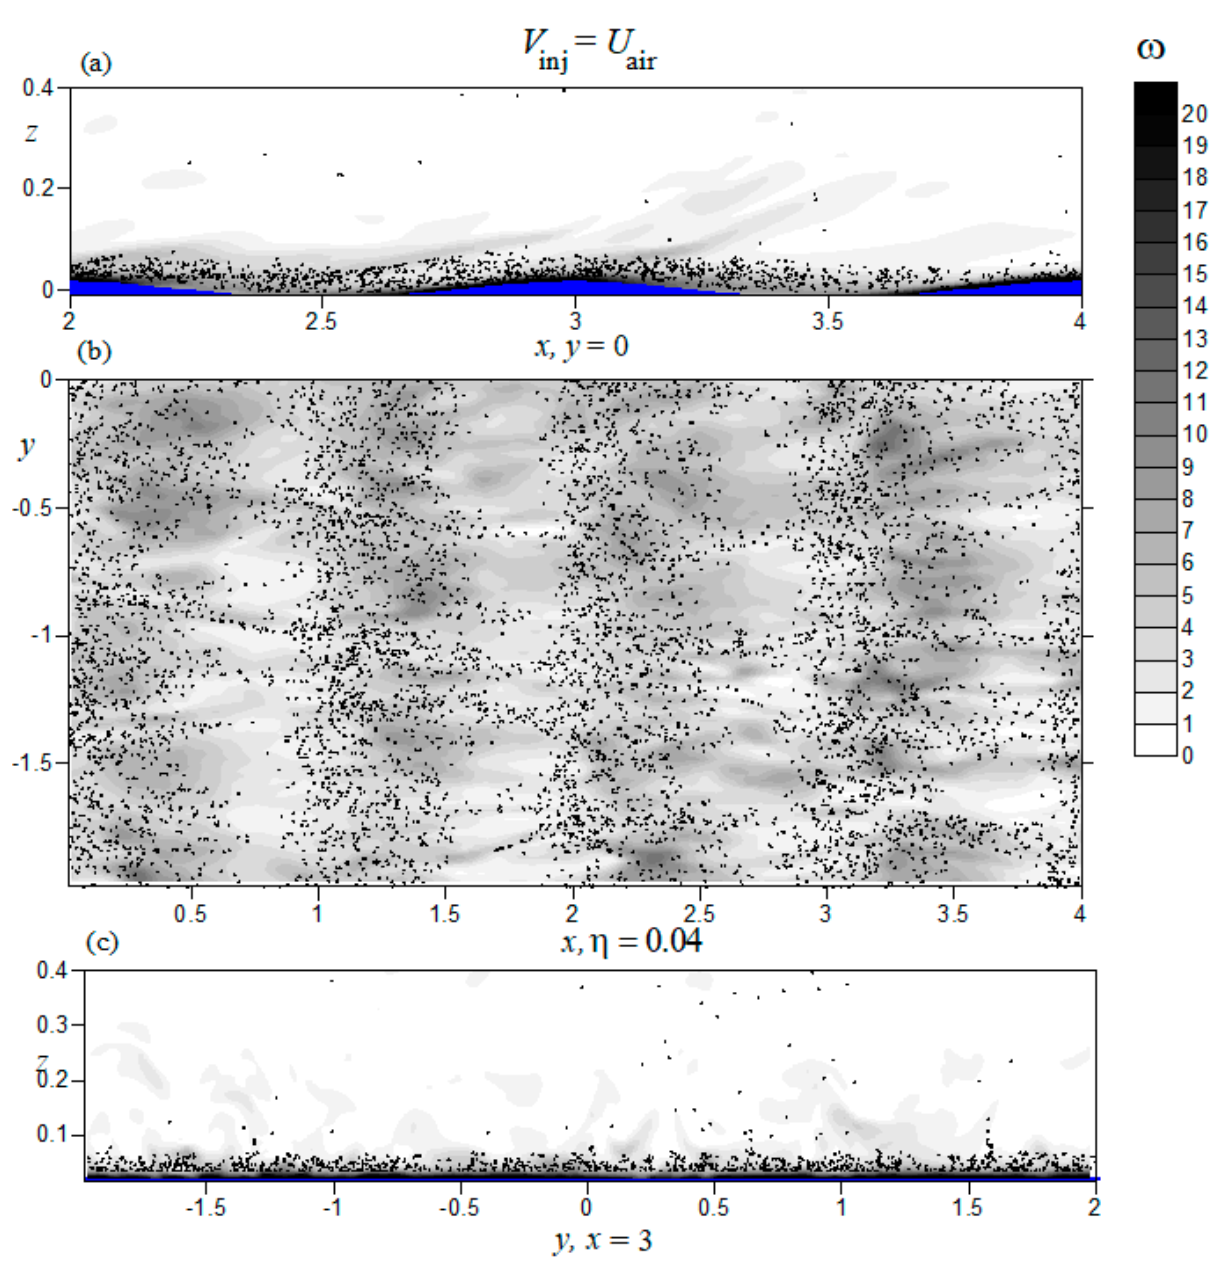
V U = . Figure 4. Figure 4. The same as in Figure 3, but for the droplet-laden flow with The same as in Figure 3, but for the droplet-laden flow with V inj = U air . inj air Figure 8 compares vertical profiles of mean air velocity, [ U + ] , stresses ( [ τ e ] and [ τ s ] ) (cid:2) (cid:3) λ 2 and vortex swirling strength, , evaluated from the respective phased-averaged fields as c described in Equations (26) and (27), for droplet-free and laden cases with different wave steepness and droplet injection scenarios. The mean air velocity in Figure 8a ( ka = 0.1) and Figure 8d ( ka = 0.2) is normalized with the friction velocity, u ∗ ≈ 0.03 U 0 , and the profiles, [ U + ] , are compared against the viscous asymptotics (in the viscous sublayer region, in a short dashed line) and the Monin–Obukhov (MO) self-similarity law in the logarithmic layer of MABL (in dashed line)